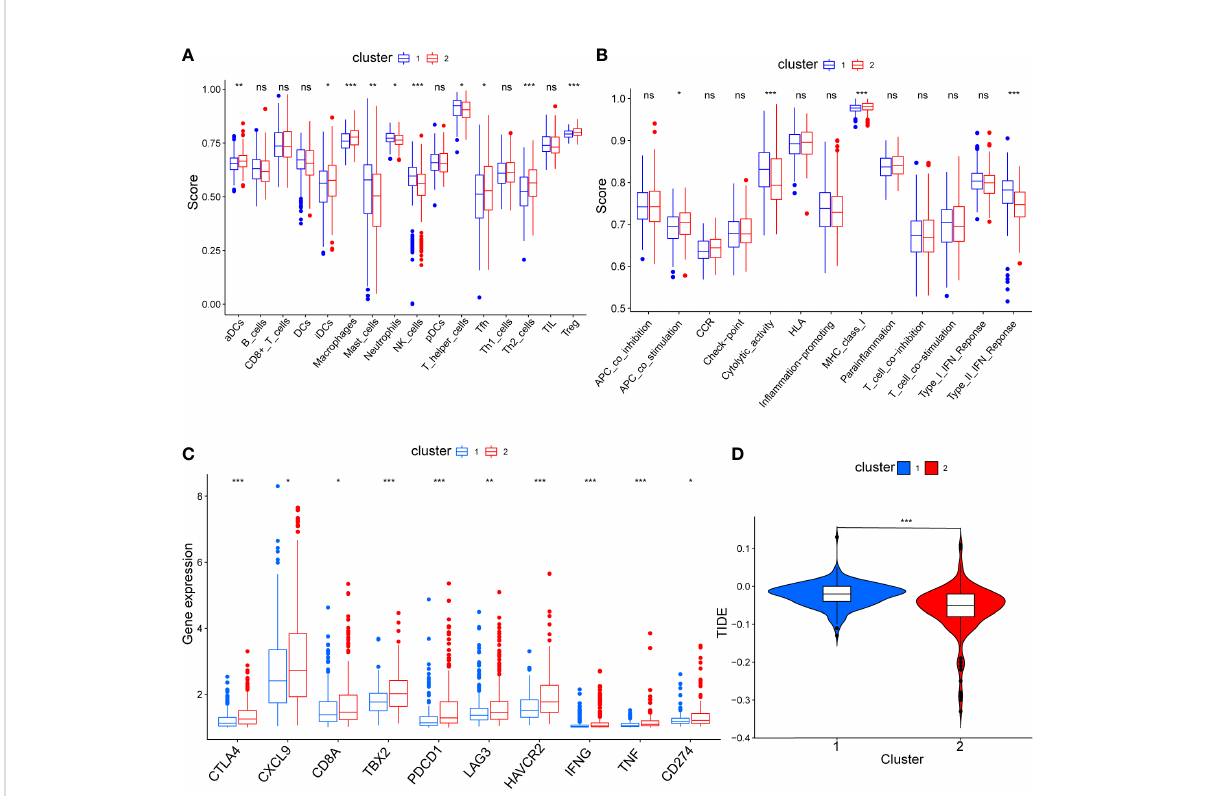
FIGURE 4 The comparison of immune status between mitophagy-related subtypes. Box plots showing the differences of in fi ltrating immunocyte abundance (A) , immune reaction activity (B) , expression of immune-checkpoint genes (C) and violin plots showing Tumor Immune dysfunction and Exclusion (TIDE) score (D) . The asterisks represent the p value (* p < 0.05; ** p < 0.01; *** p < 0.001). ns, not signi fi